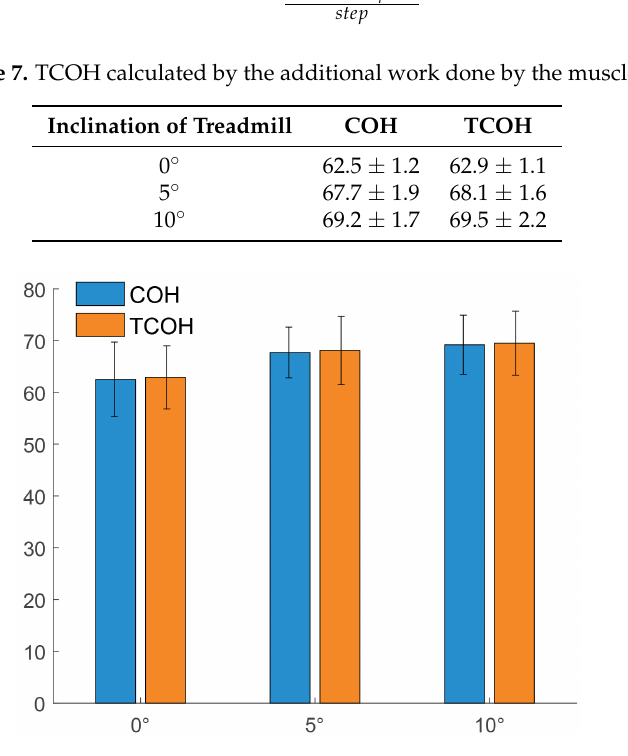
Figure 9. Bar graph of the COH and TCOH of EH device calculated by the additional work at the slope of 0°, 5° and